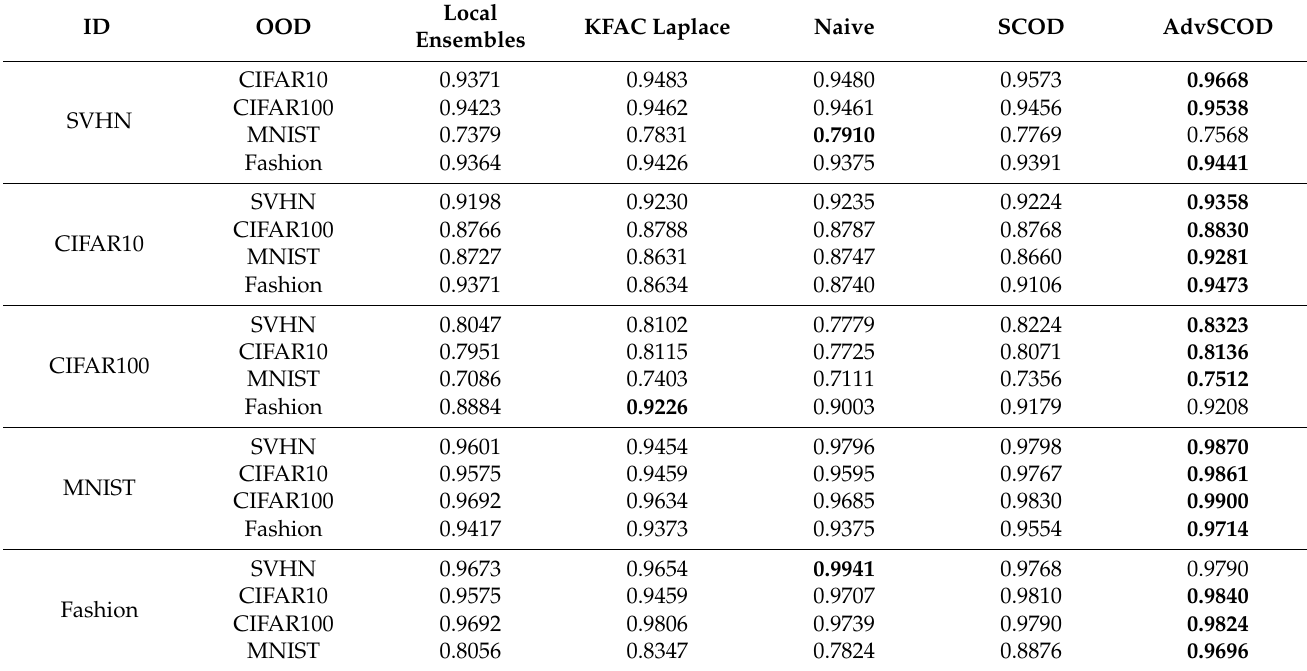
Table 1. Comparison of the OOD detection performance measured by AUROC (larger values are better). Bold numbers are superior